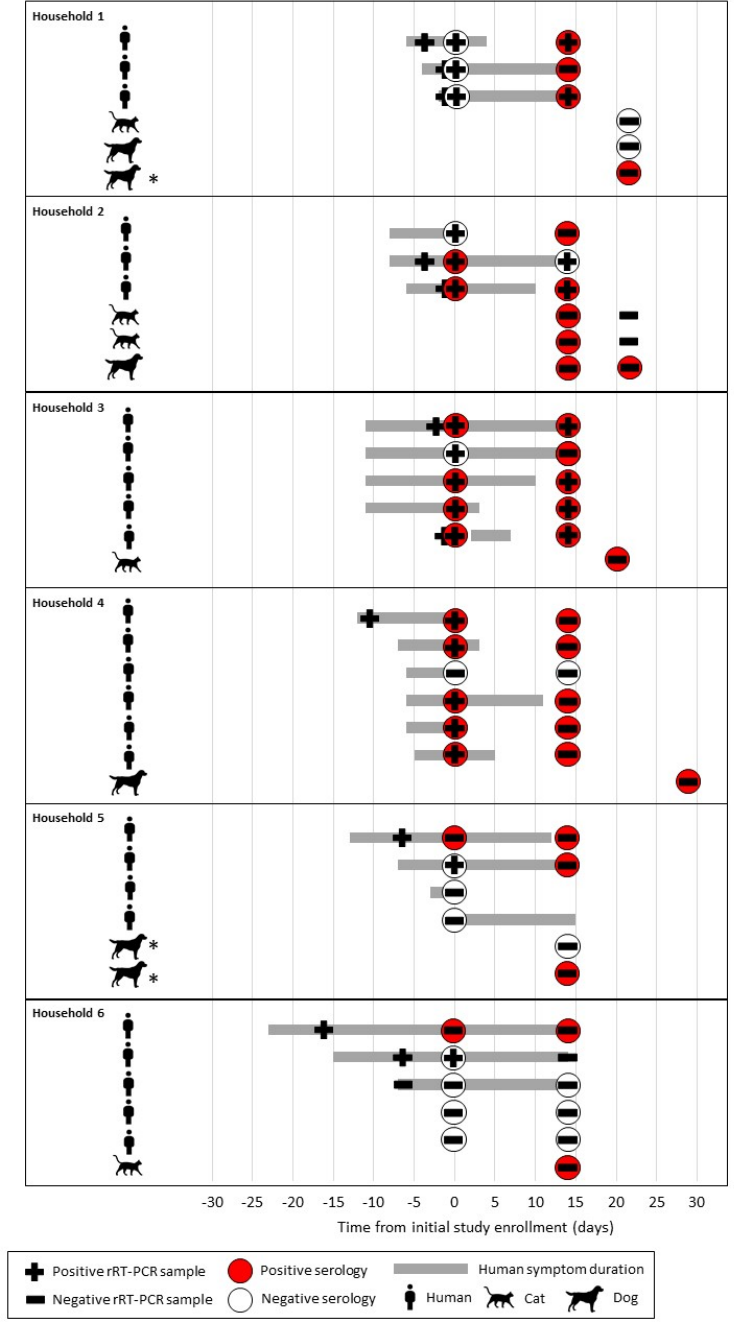
Figure 1. COVID − 19 diagnostic testing and symptom duration among humans and animals in Figure 1. COVID-19 diagnostic testing and symptom duration among humans and animals in households with a seropositive pet, One Health COVID − 19 Household Transmission Investigation, households with a seropositive pet, One Health COVID-19 Household Transmission Investigation, April–May 2020. Symptom durations are shown only for humans. Pets with clinical signs are denoted with an